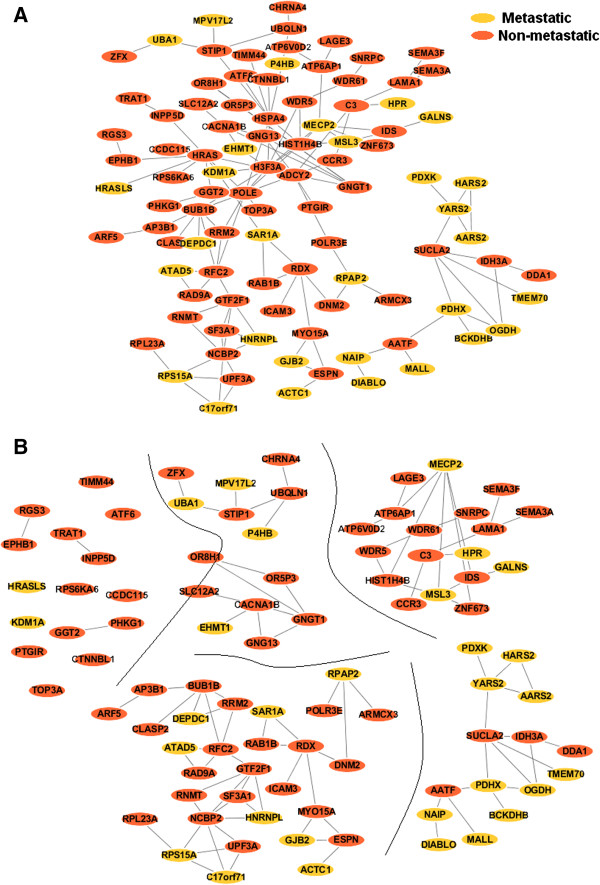
Interaction networks of DEGs constructed with Osprey. (A) Interaction networks of differentially expressed genes constructed with Osprey. (B) The integrity of the network was disrupted due to the absence of five key hub proteins (POLE (10), HRAS (9), H3F3, HSPA4, ADCY2 (8)) and connections between the nodes.